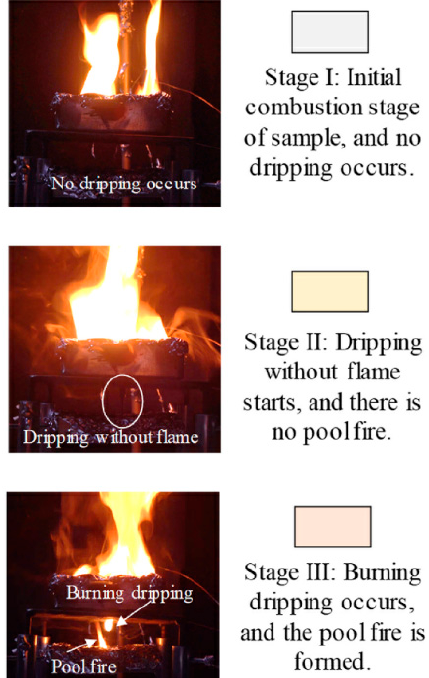
Figure 7. Stage I: combustion with no dripping; Stage II: dripping with no flame; Stage III: burning and dripping; Stage IV: formation of pool flame [15].